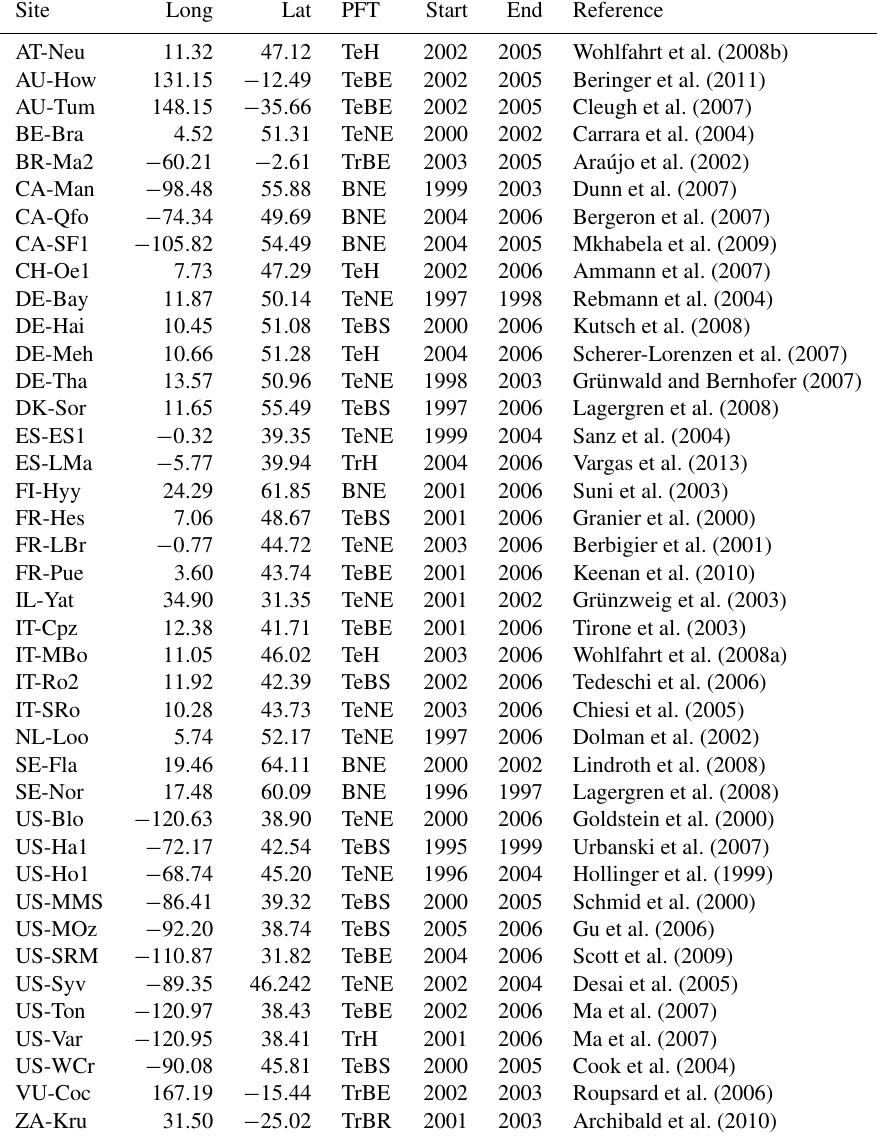
Table A1. FLUXNET